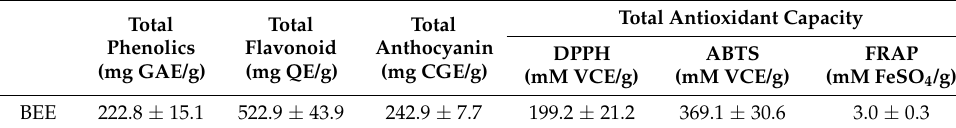
Table 1. Composition and total antioxidant capacity of